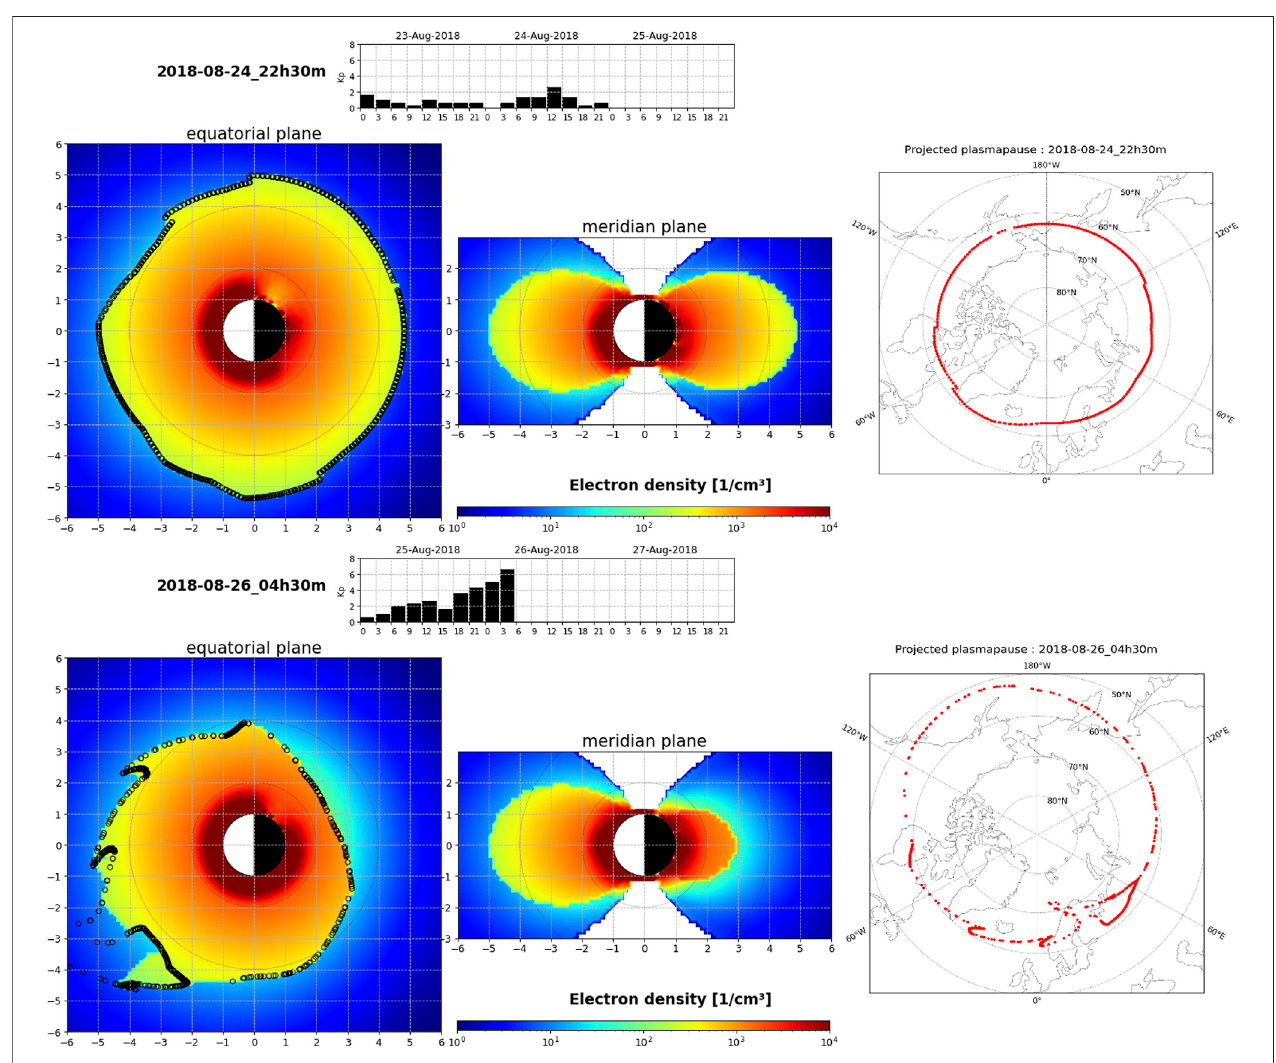
FIGURE 10 | Plasmasphere electron density in cm − 3 in (left) the equatorial plane and in (middle) the meridian plane, as well as the ionospheric footprint of the plasmapause at high latitude (right) obtained with the SPM model on (top panel) August 24, 2018 at 22h30, before the storm, and on (bottom panel) August 26, 2018 at 4h30 during the storm. The Kp index measured between 23 and August 26, 2018 4h30 is also shown in the top fi gure of each panel.